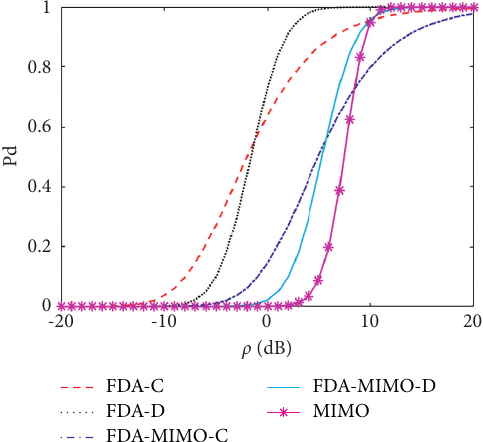
Figure 4: Illustration of target detection probability of various radar